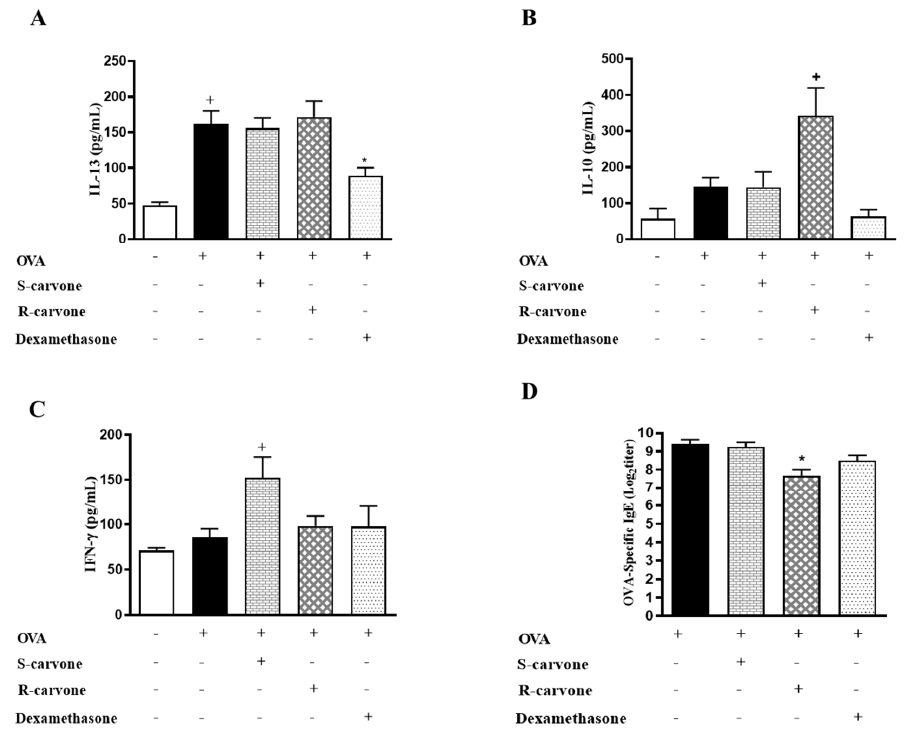
Figure 5. E ff ect of carvone enantiomers on cytokine and IgE production in BALB / c mice orally Figure 5. Effect of carvone enantiomers on cytokine and IgE production in BALB/c mice orally pre- pre-treated with R-carvone (10 mg / Kg) and S-carvone (10 mg / Kg). Concentrations of IL-13 ( A ), IL-10 ( B ), treated with R-carvone (10 mg/Kg) and S-carvone (10 mg/Kg). Concentrations of IL-13 ( A ), IL-10 ( B ), IFN- γ ( C ) in the BAL were determined by ELISA. Titers of OVA-specific IgE in the serum